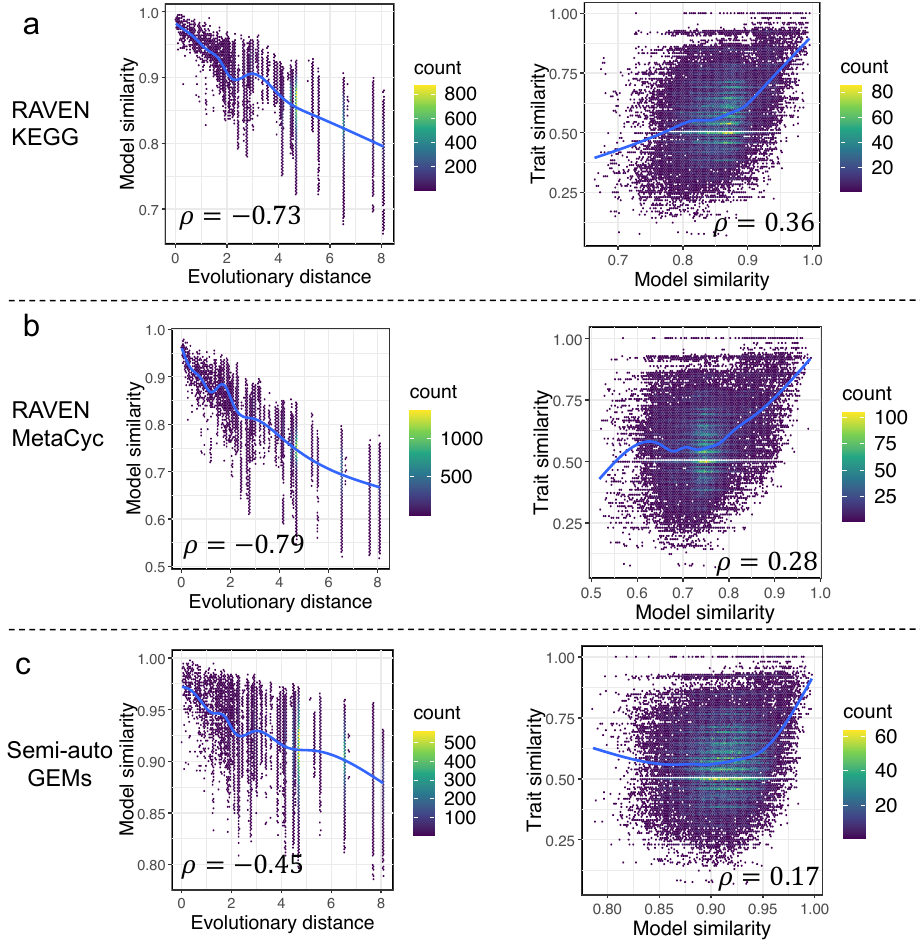
Figure 5. Correlation analyses among model similarity, evolutionary distance, and trait similarity across 332 yeast species for draft GEMs built using RAVEN getKEGGModelForOrganism ( a ), get- MetaCycModelForOrganism ( b ), and the semi-auto GEMs from the template model Yeast8 ( c ). All the fitting shown as blue lines was based on a generalized additive model, if not stated in this work. It shows that various pairings of two yeast species may have a comparable evolutionary distance (Figure 5). As a result, the genotype similarity between any two yeast species was further estimated based on the ortholog gene relationships from the study [1] (Material and Methods). The correlation between evolutionary distances and genotype similarity was initially assessed, and the associated Pearson coefficient was − 0.69 ( p -value < 2.2 × 10 − 16